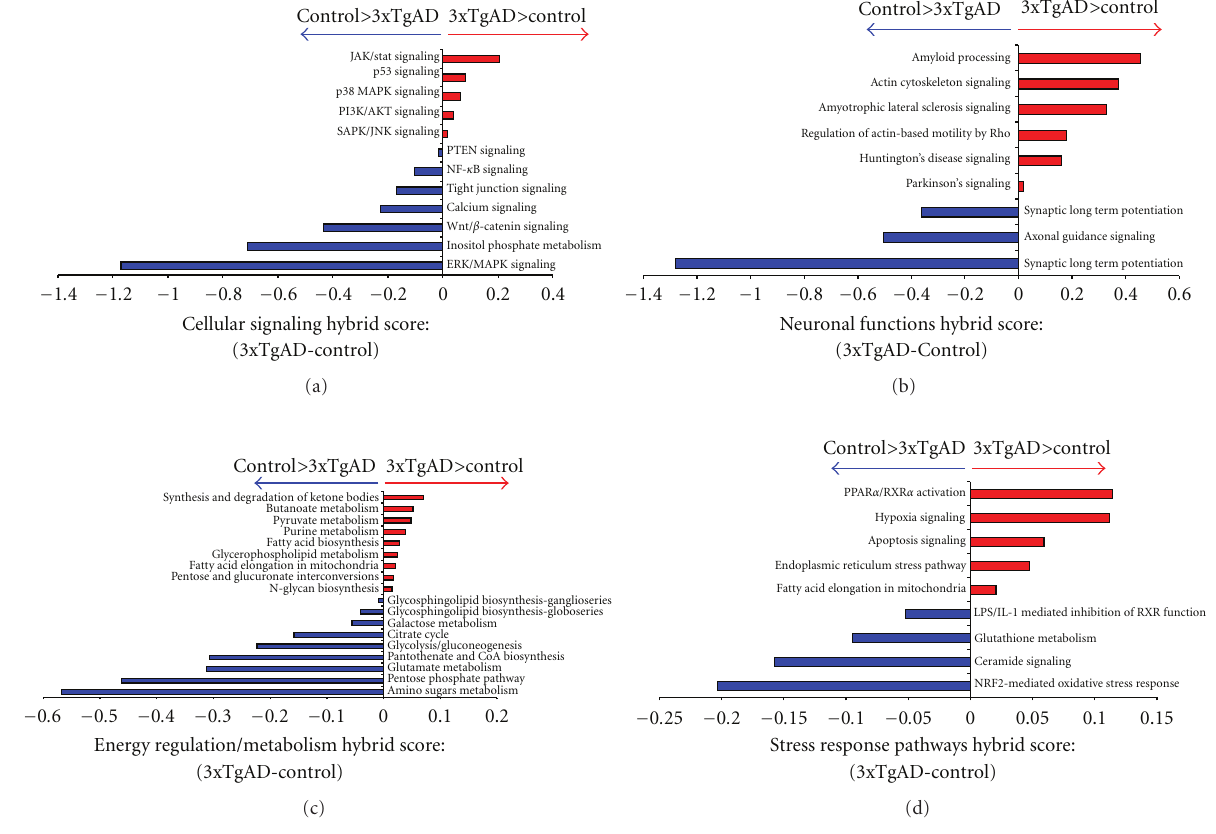
Figure 4: Functional pathway informatic clustering of control and 3xTgAD lipid raft proteins. (a) Subtractive representation of hybrid score generation after clustering of lipid raft proteins from control and 3xTgAD animal rafts into cellular signaling pathways. The hybrid scores were generated by multiplication of the protein enrichment ratio of the specific pathway with the negative log that enrichment (see Section 2). The data is presented as a numerical value of the control pathway hybrid score subtracted from the 3xTgAD pathway hybrid score. Pathways in which the score in 3xTgAD was greater than the control are denoted in red; pathways in which the control hybrid score is greater than the 3xTgAD hybrid score are denoted in blue. A similar depiction format is employed for di ff erential analysis of control versus 3xTgAD Neuronal Function pathways (b), Energy Regulation/Metabolism pathways (c), and Stress Response pathways